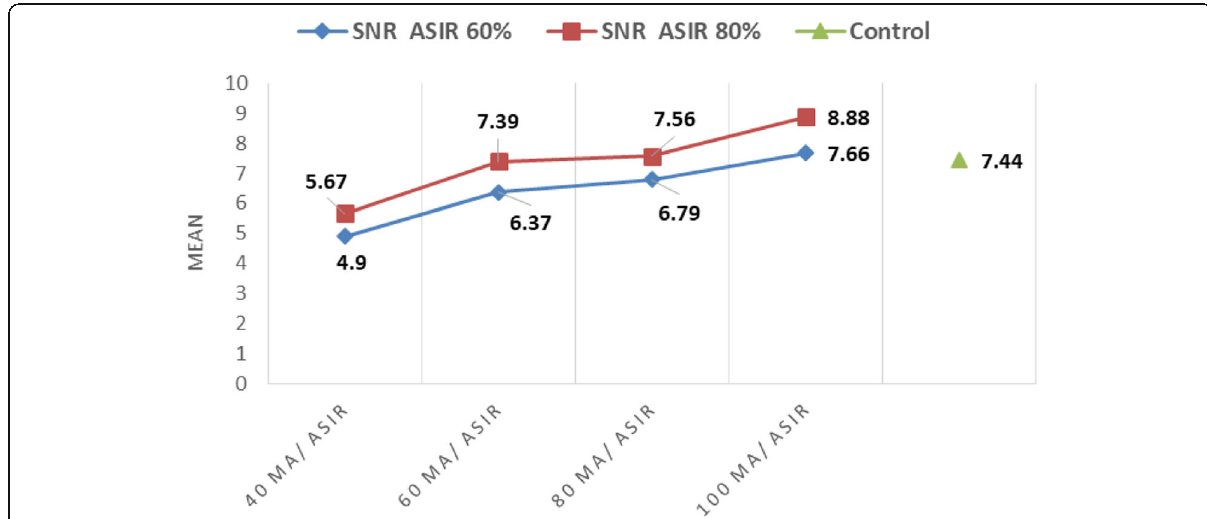
Fig. 3 The mean values of measured SNR in the CT images with the different used reduced mAs, with 60% ASIR-V (blue) and 80% ASIR-V reconstruction (red) of the ASIR group and non-ASIR standard dose (control) group CT images